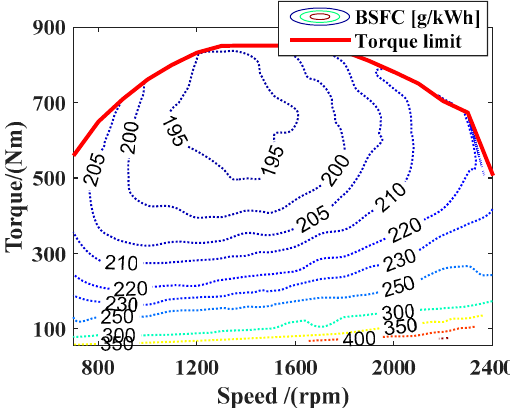
Figure 5. Brake-specific fuel consumption map of the engine.